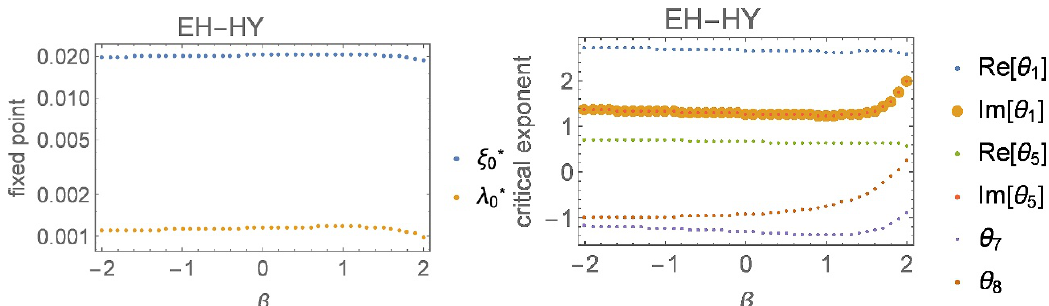
Figure 9 . The dependences of the stable (cid:12)xed point and the stable critical exponent on (cid:12) in the \EH-HY"